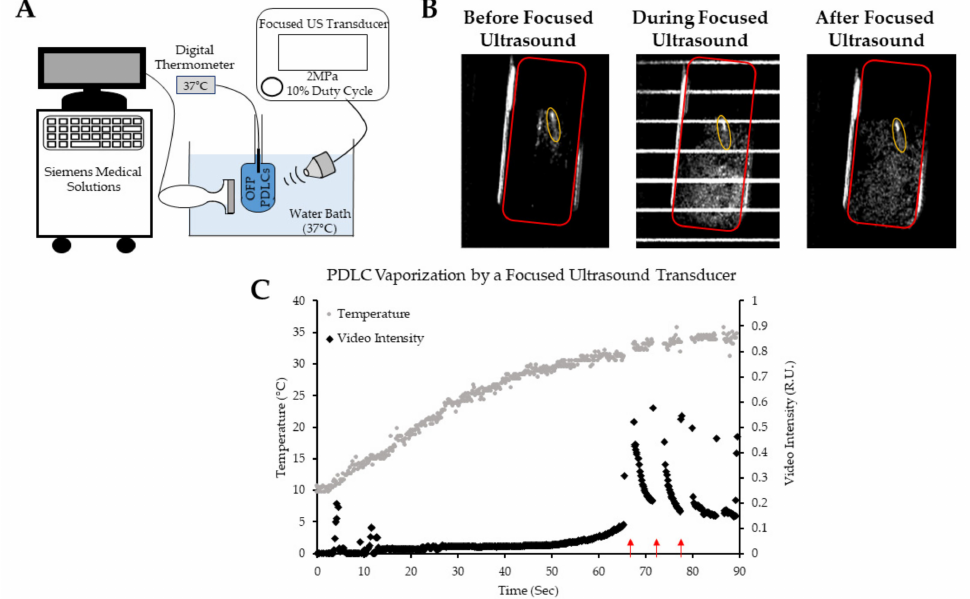
Figure 9. Visualizing focused ultrasound-induced octafluoropropane droplet vaporization using a clinical scanner. ( A ) Schematic of the setup used for acquiring B-mode images to monitor OFP droplet vaporization. ( B ) B-mode images showing the vaporization of OFP droplets before, during, and after focused ultrasound application. The region of interests (ROIs) used for intensity quantifications are shown. The temperature probe inside of the tube can be seen in the B-mode images and is shown by the yellow ellipse. ( C ) Video intensity within the chamber (ROIs showed in red). The red arrows show sonication starting